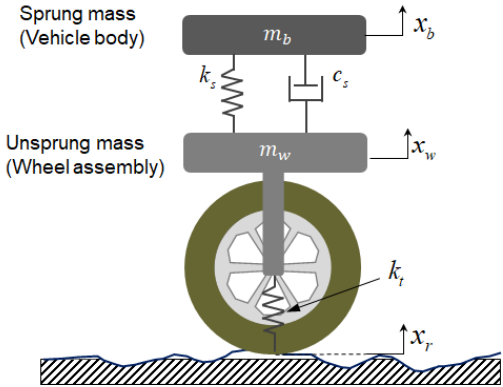
Figure 2. Schematic of quarter-car suspension model consisting of two primary masses (sprung and unsprung).